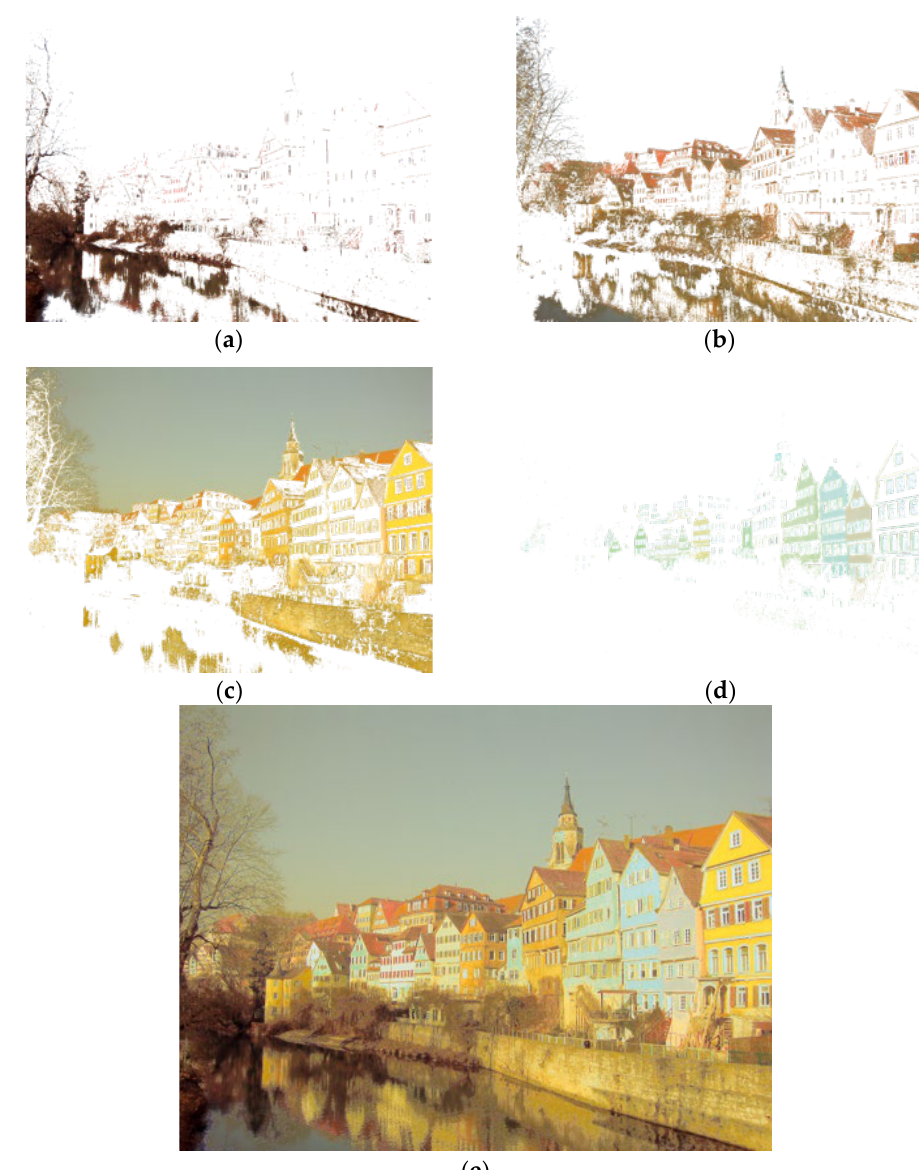
Figure 6. The result of the adaptive multilevel image color transfer. ( a – d ) Color transfer with each region. ( e ) The result of overlapping the image ( a – d ).